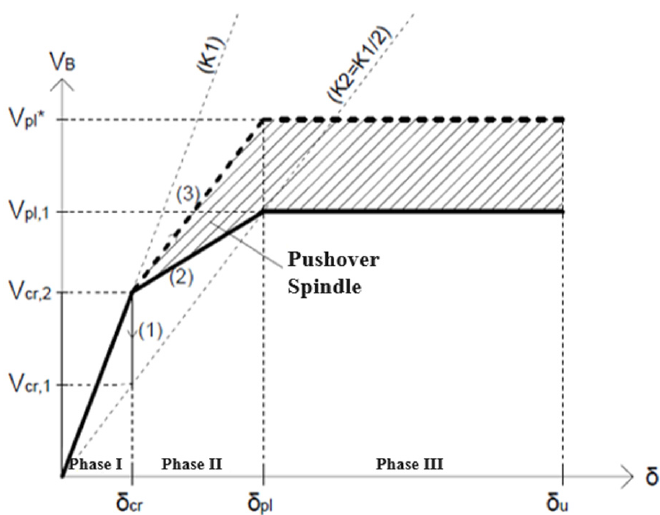
Figure 3. Possible post-critical behavior of the compressed diagonal.